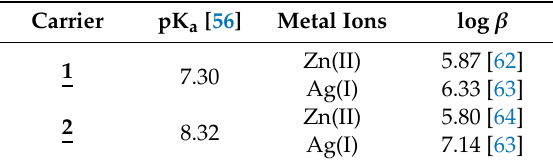
Table 4. The dissociation constants (pK a ) of 1-hexylimidazole ( 1 ) and 1-hexyl-2-methylimidazole ( 2 ) and the stability constants (log β ) their complexes with Zn(II) and Ag(I)